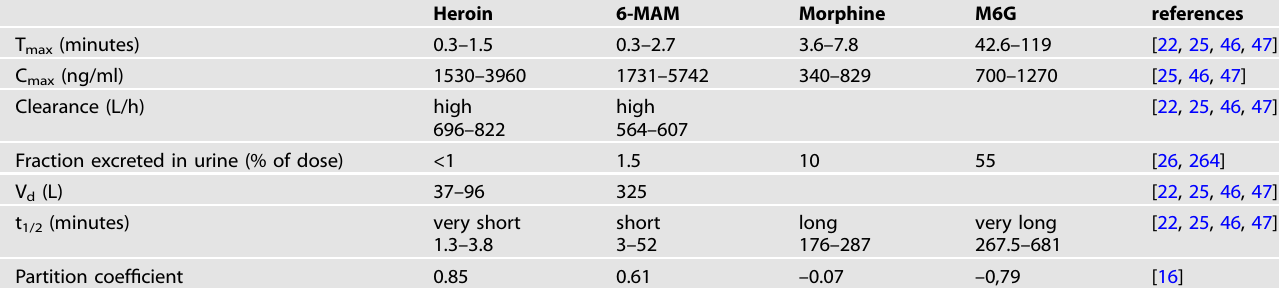
Fig. 1 Molecular structure of heroin and its metabolites. Schematic representation of the metabolic pathway of heroin with the sequential breakdown into the main metabolites. The involved enzimatic processes are listed in italics. Table 1. Overview of the principal pharmacokinetic parameters and characteristics of heroin and its metabolites following an intravenous administration of heroin (120 – 450 mg) in